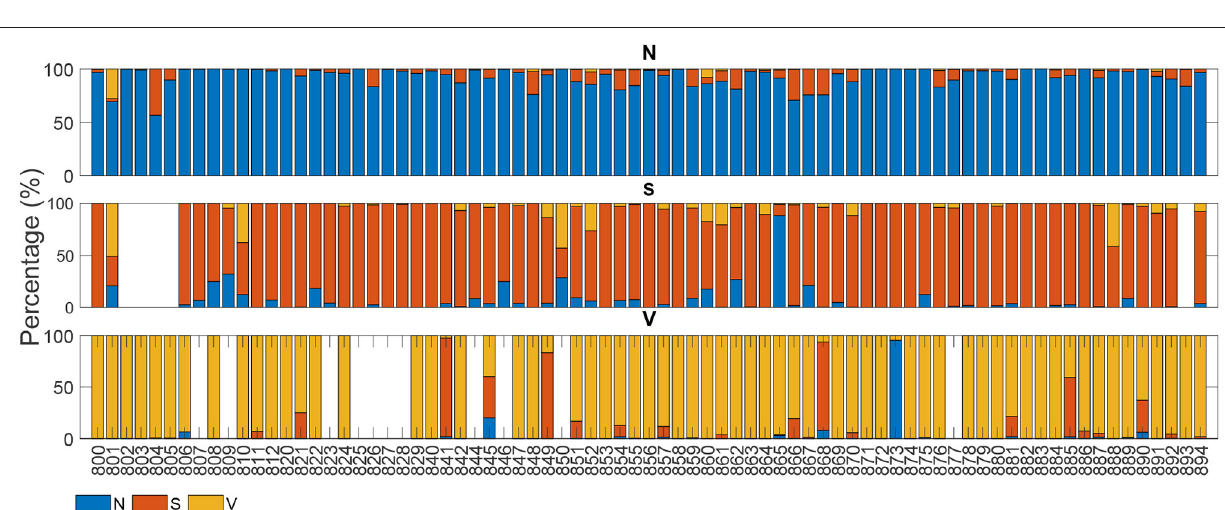
FIGURE 5 | Classification of each of the SVDB signals’ beats. Each sub-graph represents the classification distribution of the beats of the three classes considered: N , S , and V . Each bar in each sub-graph represents the total number of beats of that class of a single patient and how they have been classified (in percentage). The x -axis represent the different patient